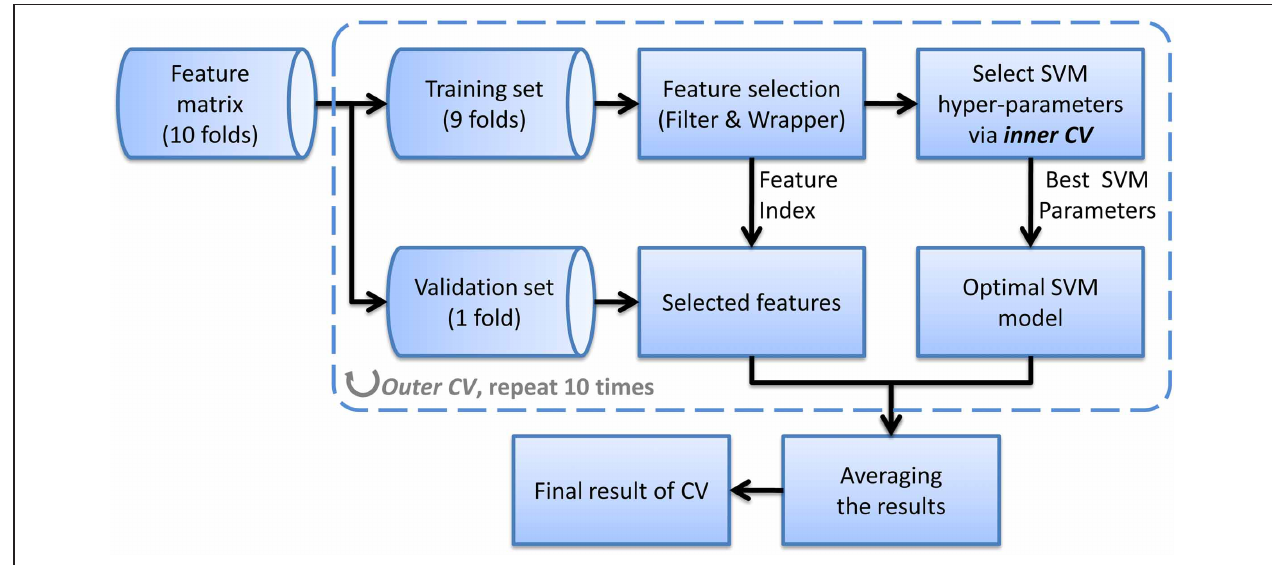
FIGURE 1 | The flow chart of the nested CV classification method using a single